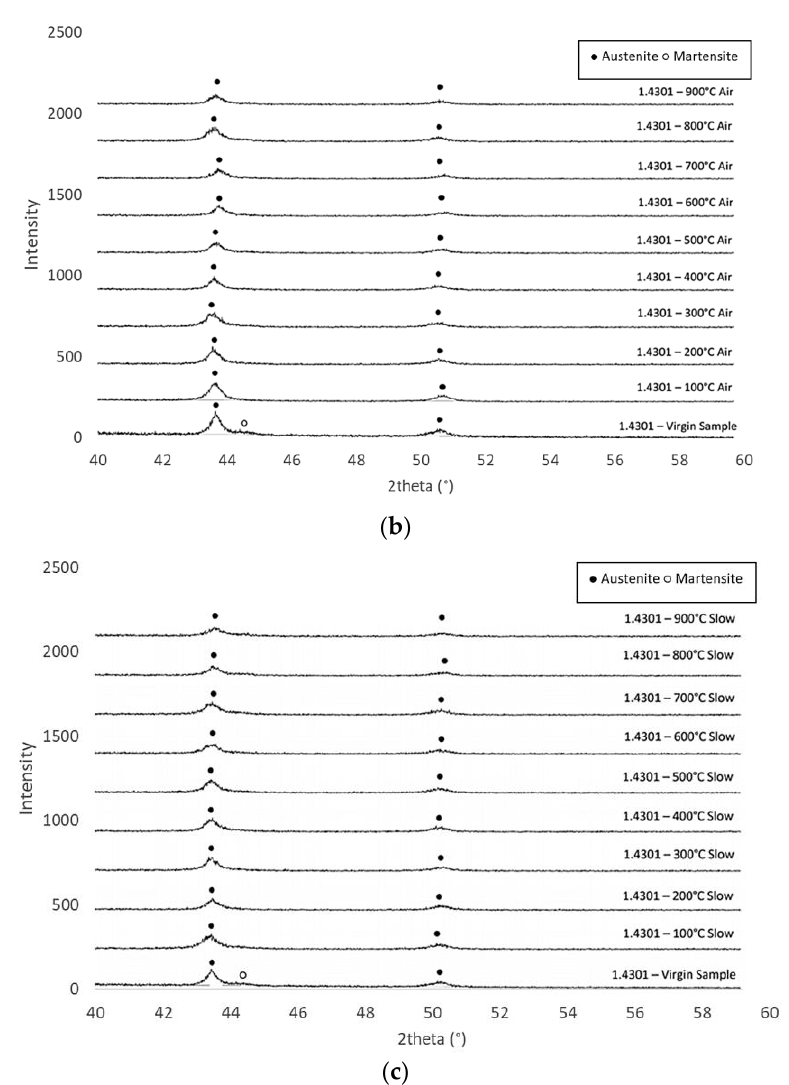
Figure 12. Data from the diffractograms for grade 1.4301 reinforcing bars that were heated to various temperatures as indicated and then cooled ( a ) quickly by quenching in cold water, ( b ) naturally in air, and ( c ) slowly in the furnace.